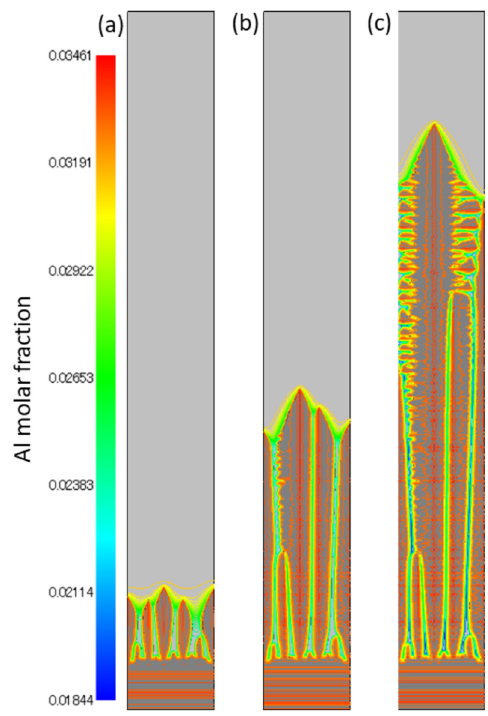
Figure 7. Temporal Al molar fraction distributions with phase distributions at the 10-layer position for ( a ) 0.36, ( b ) 0.44, and ( c ) 0.54 s.